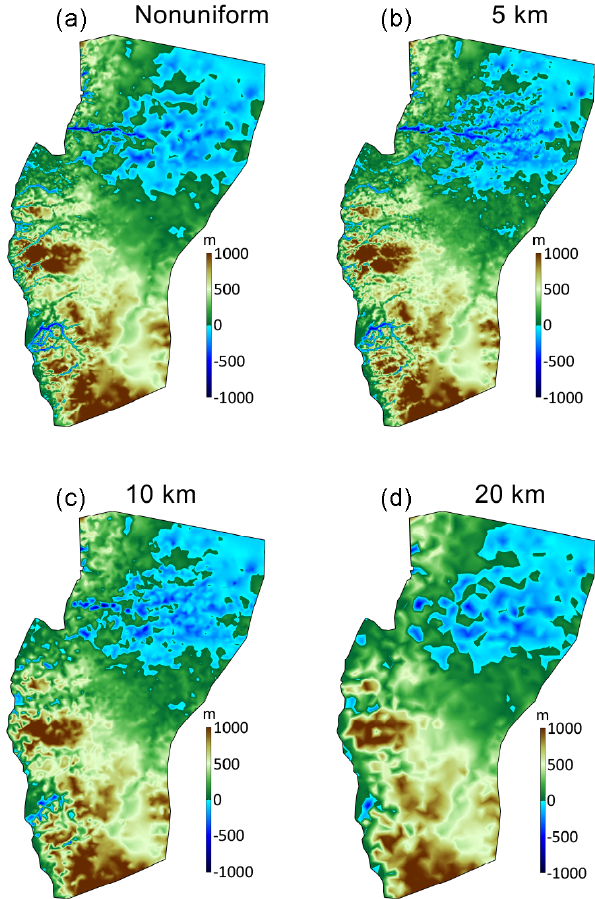
Figure 2. Associated bed topography maps for the nonuniform high-resolution mesh (a) , uniform 5km mesh (b) , uniform 10km mesh (c) , and uniform 20km mesh (d)